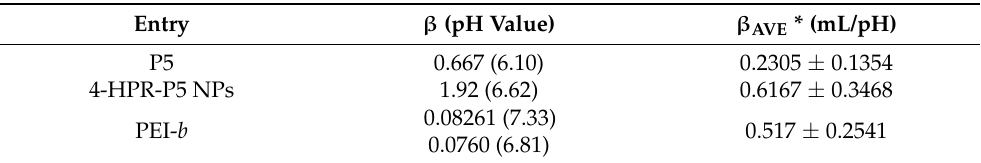
Table 1. Maximum β value and β AVE of 4-HPR-P5 NPs, P5 alone, and commercial polyethyleneimine (PEI- b ) in the pH range 4.5–7.5 computed from potentiometric titration